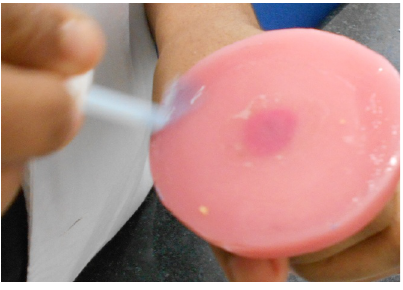
Figure 2. Applica3on of adhesives.